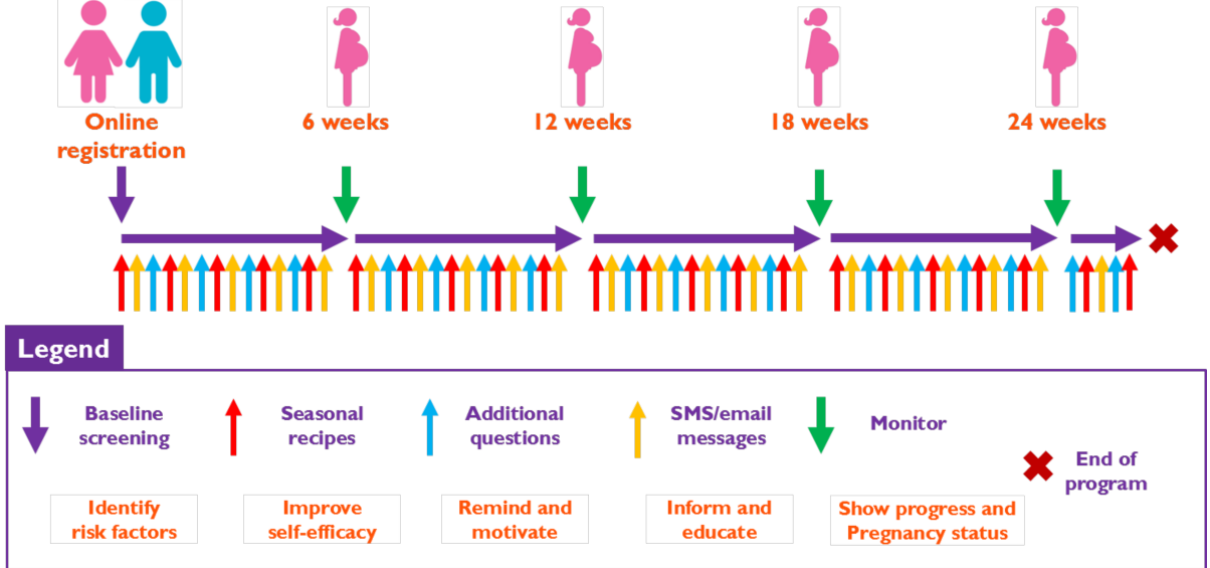
Figure 1. Overview of both the intervention and control groups during their enrollment in the Smarter Pregnancy randomized controlled trial.